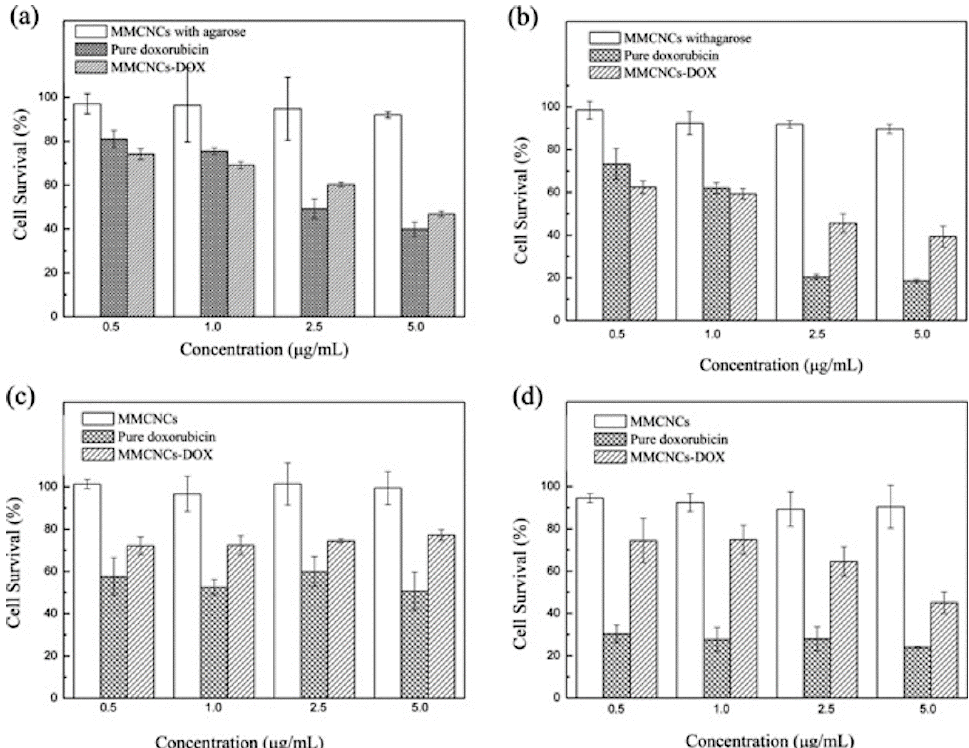
Figure 8. ( a , b ) Survival of SGC7901 cells in four different concentrations of the MMCNCs, pure DOX, and MMCNCs-DOX after incubation with cells for ( a ) 24 and ( b ) 48 h. Graphs were plotted with DOX concentrations of 0.5, 1.0, 2.5, and 5.0 µg mL − 1 . c, d) Survival of HEK 293T cells in four different concentrations of the MMCNCs, pure DOX, and MMCNCs-DOX after ( c ) 24 and ( d ) 48 h of incubation. Graphs were plotted with DOX concentrations of 0.5, 1.0, 2.5, and 5.0 µg mL − 1 . Reprinted with permission from ref [267]; Li et al., Small 8 (2012) 2690–2697, Copyright (2012) John Wiley and Sons Inc.